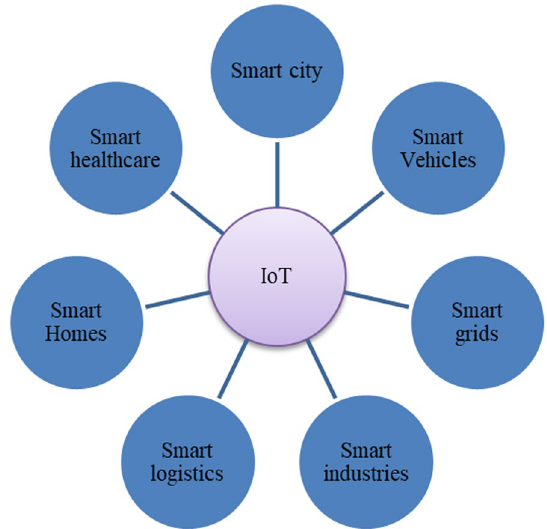
Fig. 1 Schematic diagram of the Internet of Things